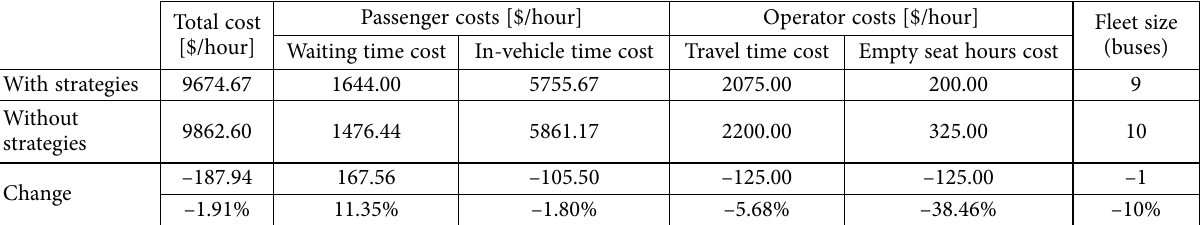
Table 4. Effects for passengers and operator introducing